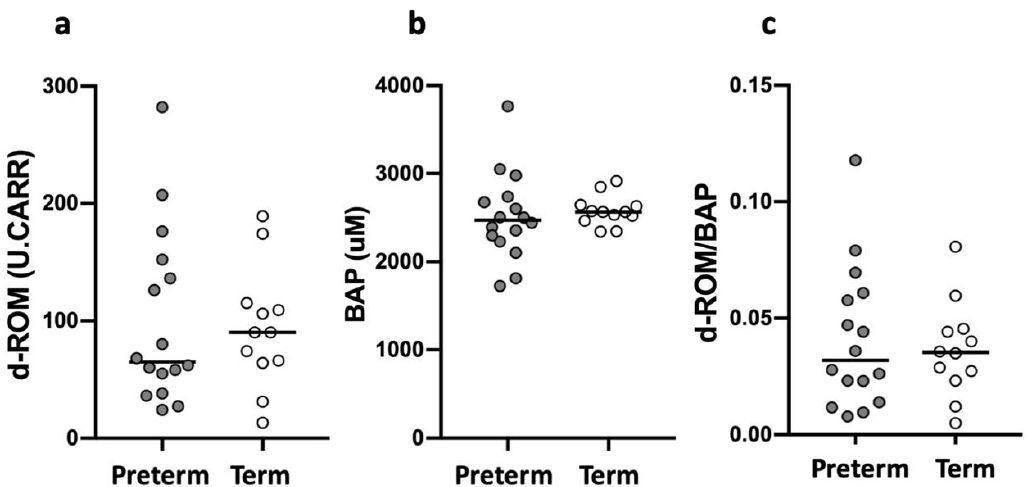
Figure 2. Oxidative stress, antioxidant capacity, and oxidant to antioxidant ratio in preterm and term sSGA infants. White circles represent term infants, and gray circles represent preterm infants. d-ROM: derivative of reactive oxidative metabolites; BAP: biological antioxidant potential. ( a ) d-ROM; ( b ) BAP; ( c ) d-ROM/BAP.